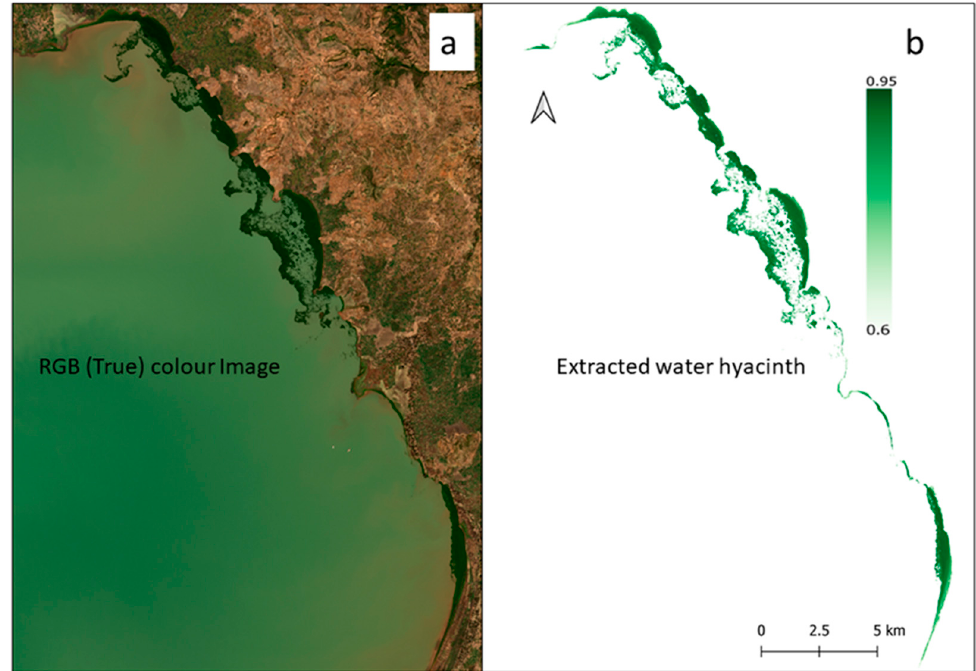
Figure 6. ( a ) RGB (red ‐ green ‐ blue) band composite on 17 January 2020 indicating the water hyacinth area on the northeastern part of Lake Tana; ( b ) water hyacinth map extracted from the Sentinel ‐ 2 Level ‐ 2 satellite image (Sen2Cor) using the NDVI values with the range from 0.6 to 0.95.